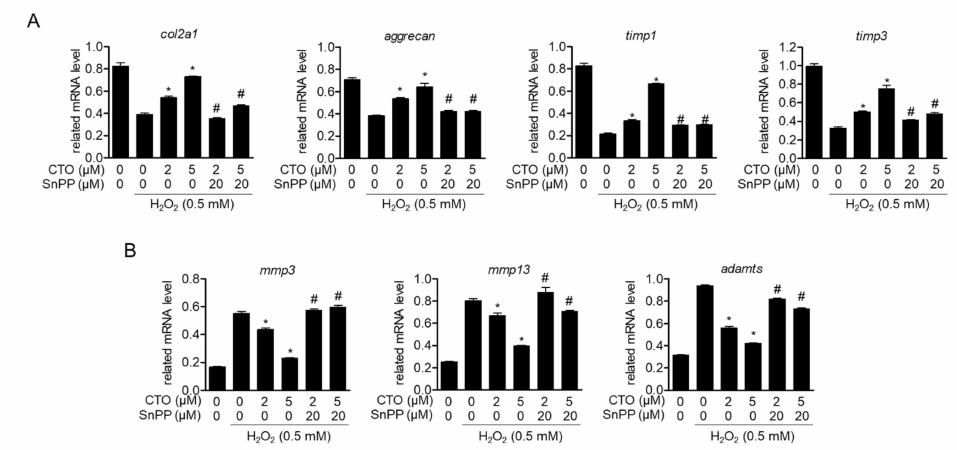
Figure 7. Induced HO-1 by CTO regulates chondrocytes-specific genes and expression of MMPs in H 2 O 2 treated SW1353 cells. ( A , B ) SW1353 cells were pre-treated with or without 20 µ M SnPP for 1h. Then cells were treated with the indicated concentration of CTO (2 or 5 µ M) for 6 h, and incubated with 0.5 mM H 2 O 2 for 2 h. The mRNA levels of cartilage-specific core genes and timps ( A ) and mmps genes ( B ) were determined by real-time PCR analysis. The results were normalized to gapdh expression.